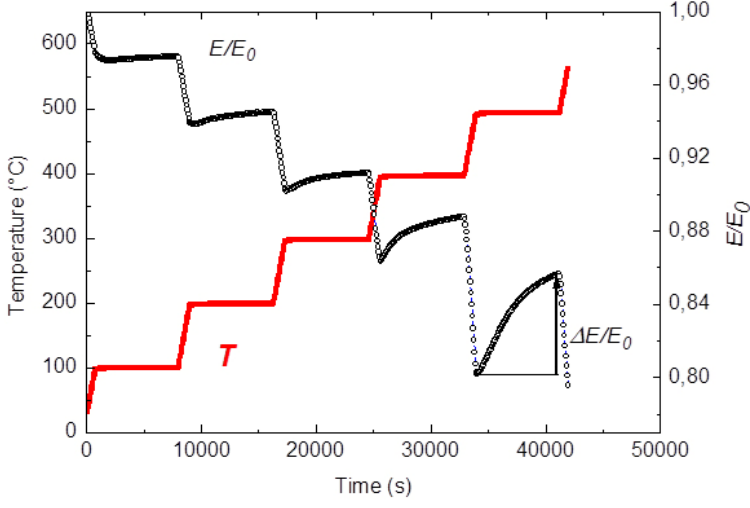
Figure 1. AISI 304 steel: dynamic modulus E normalized to its initial value E 0 evolution during isothermal stages at increasing temperature (steps of 100 °C). The temperature T curve is plotted in red.